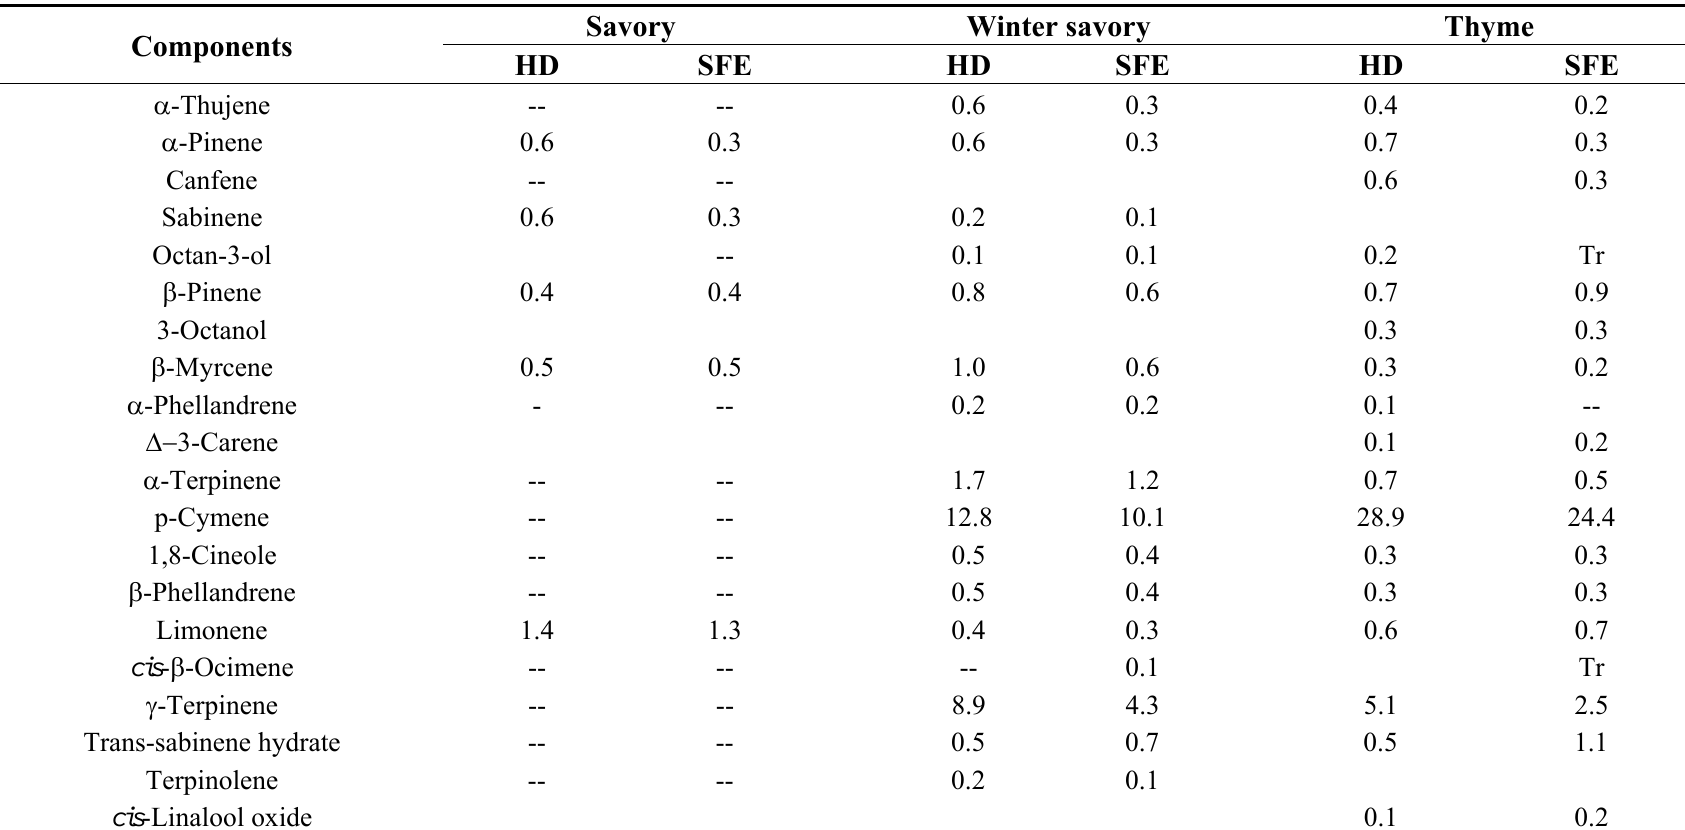
Table 3. Percentage composition of the savory, winter savory and thyme volatile oils obtained by hydrodistillation and supercritical fluid extraction, in the conditions report in table.